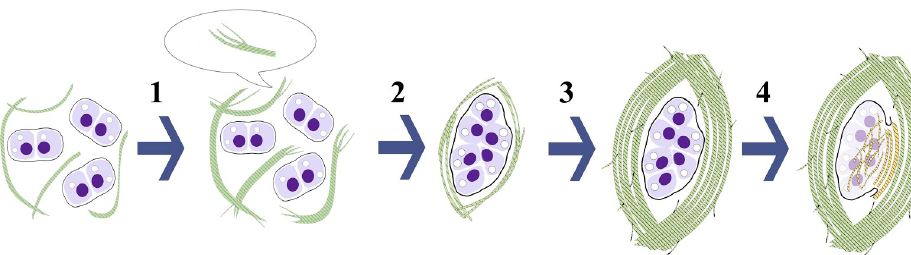
Fig 14. Subsequent development of amianthoid transformation (AT) of costal cartilage matrix. Collagen II fibrils (green) of the intact matrix transforms into amianthoid fibers (AFs) of “fine-fibred” AT area (1). Then, lateral aggregation of AFs leads to the formation of “canonical” or “intertwined” AT areas (2, 3) with more aligned arrangement of AFs surrounding large lacunae with dystrophic chondrocytes. Finally, the lacunae degenerate (4) with the destruction of the capsule (black border) leaving behind lens-shaped cavities with “intralacunary” AT areas (yellow) composed of collagen type II fibrils.